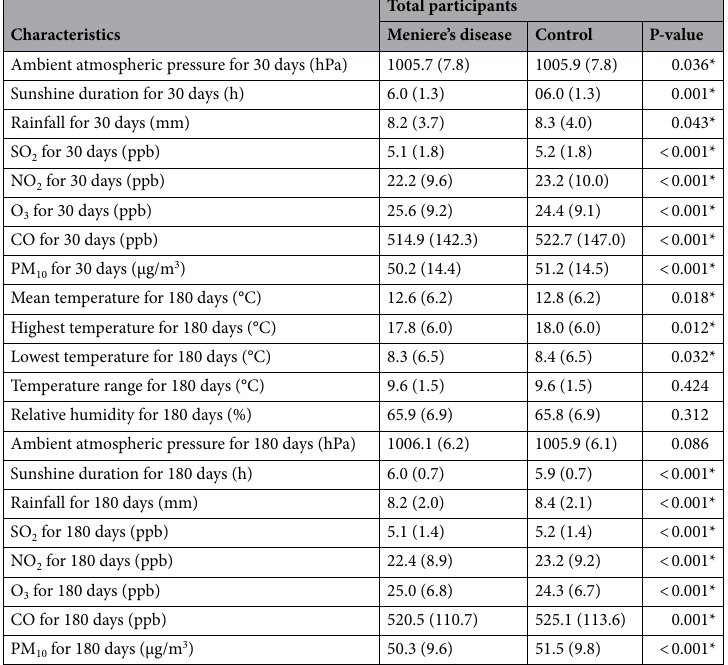
Table 1. General characteristics of participants. BMI body mass index (kg/m 2 ), ppb Parts per billion, ppm Part per million (= 1000 ppb), SD standard deviation. *Chi-square test or independent T-test. Significance at P < 0.05.